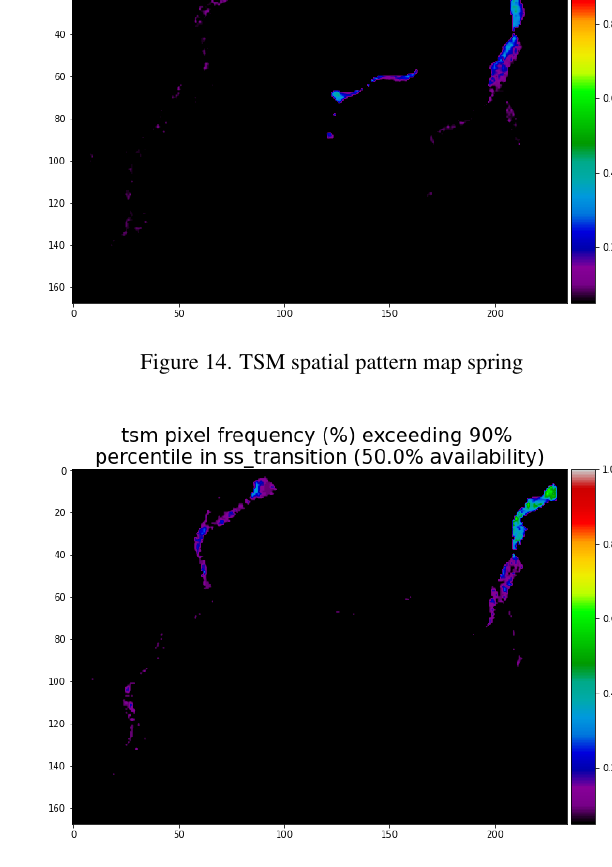
Figure 15. TSM spatial pattern map spring-summer transition